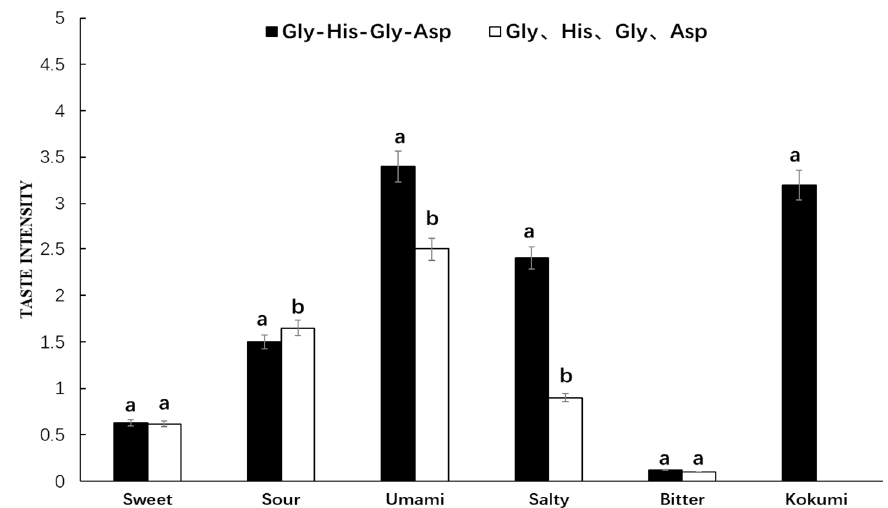
Figure 6. Sensory evaluation of peptide Gly-His-Pro-Asp and its mass-equivalent amino acids mixture in chicken broth. a, b The different letters in the same group represent that there are significant differences at the level of p < 0.05, and the same letters represent no significant difference.